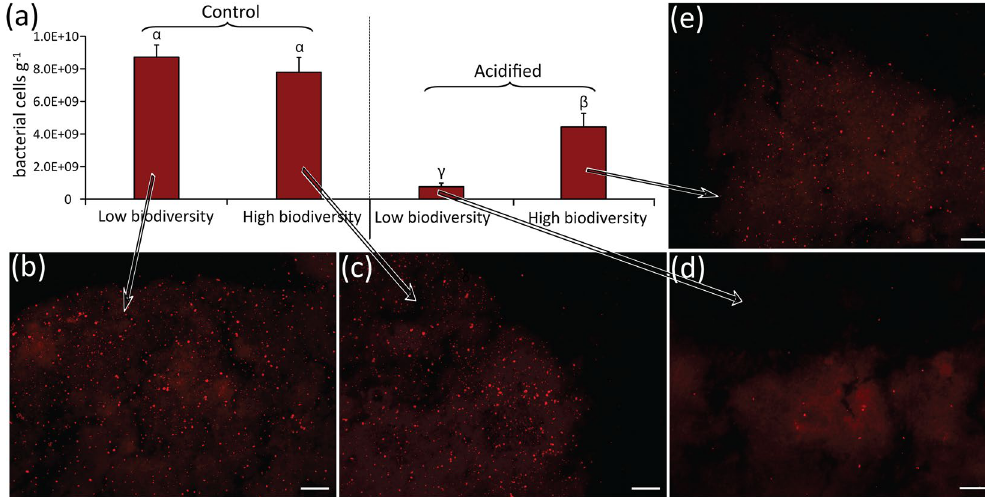
Figure 4. Impact of acidification on the association between the sponge Hemimycale columella and calcibacteria. The bar plot ( a ) reports the number of bacterial cells per gram of sponge dry weight, as determined by CARD-FISH on calcibacteria extracted from fresh H. columella sponge tissues. Average values and standard deviations are shown for samples collected at the end of the experiment (86 d) from acidified and non-acidified mesocosms containing low-biodiversity assemblages (i.e., only 6 families), or high-biodiversity assemblages (i.e., 11 families). The epifluorescence microscopy images show sections of the corresponding samples of H. columella sponge tissues from which calcibacteria were extracted, analyzed in parallel by CARD- FISH. ( b ), control (low-biodiversity, 6 families); ( c ), control (high-biodiversity, 11 families); ( d ), Acidified (low- biodiversity, 6 families); E, acidified (high-biodiversity, 11 families). Scale bar: 40 µ m. Greek letters are used to highlight the significant differences (p < 0.01) among the reported values, with α > β > γ